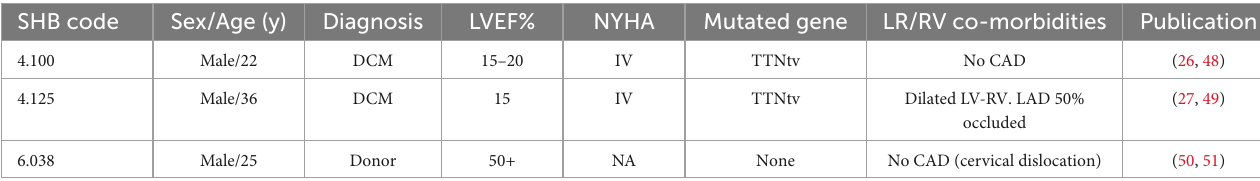
TABLE 1 A summary of the details of the LV samples used in this